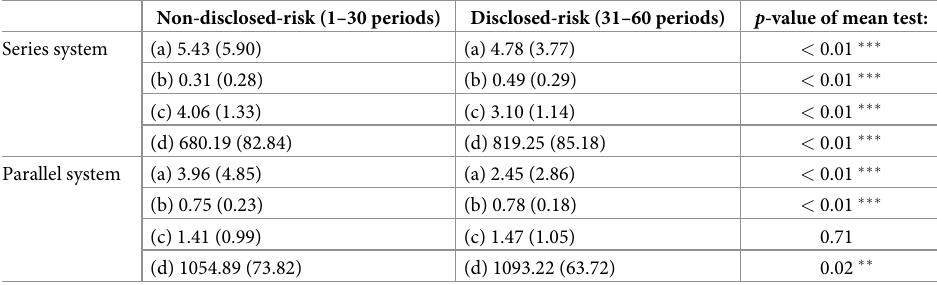
Table 4. Summary of the experimental results.